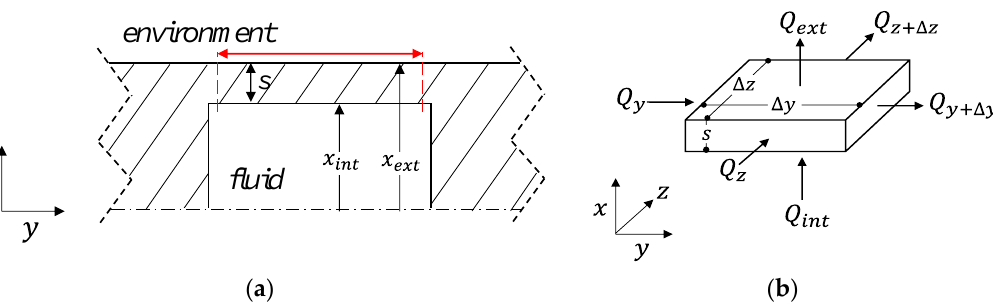
Figure 3. Cross-sectional view of a generic FPPHP channel within the adiabatic section ( a ) and three-dimensional generic wall element ( b ).